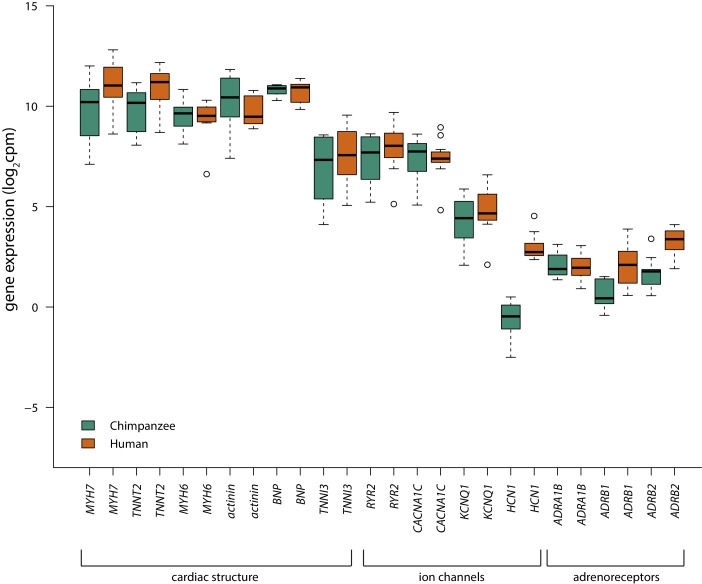
Range of cardiomyocyte genes are expressed in human and chimpanzee iPSC-CMs.Log2cpm values of cardiac structure, ion channel and adrenoreceptor genes expressed in cardiomyocytes (Burridge et al., 2014) in human (orange) and chimpanzee (green) iPSC-CM samples. Condition A (normoxia) values are plotted for each sample.